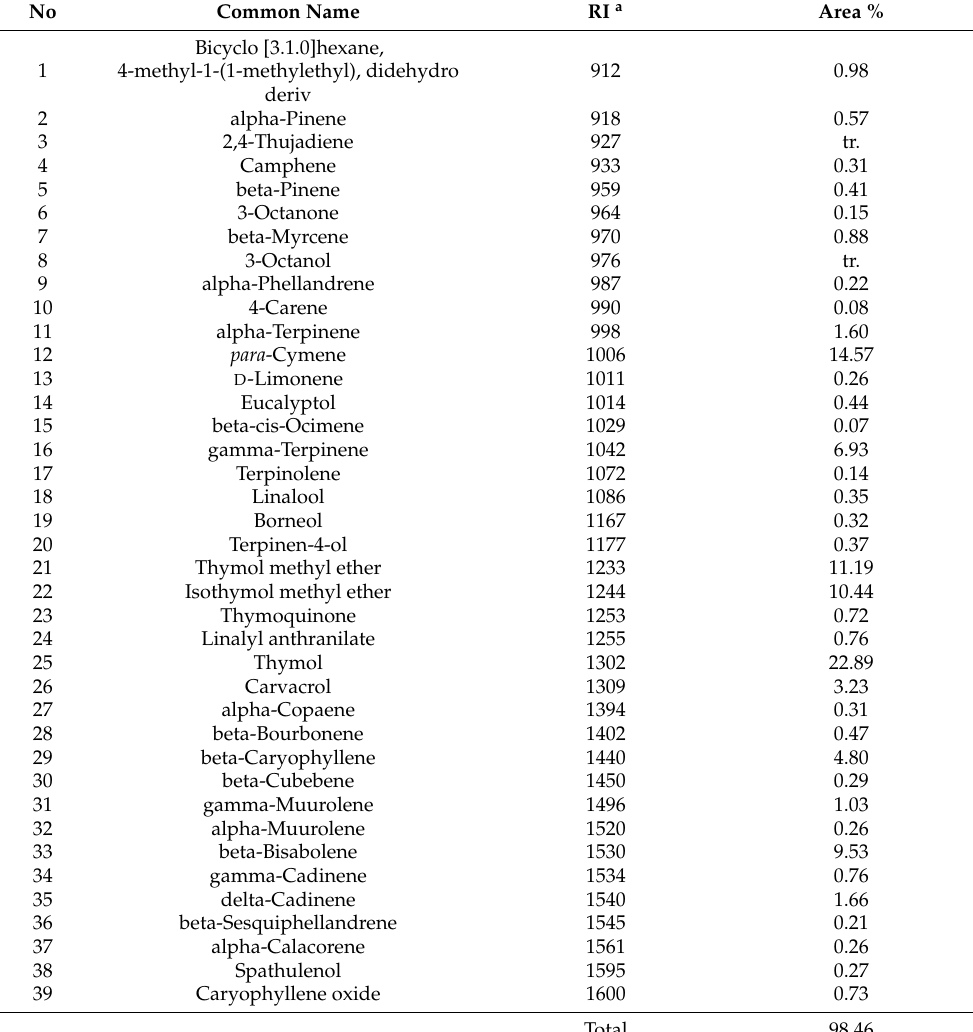
Table 2. Chemical composition of the essential oil isolated from T. pulegioides